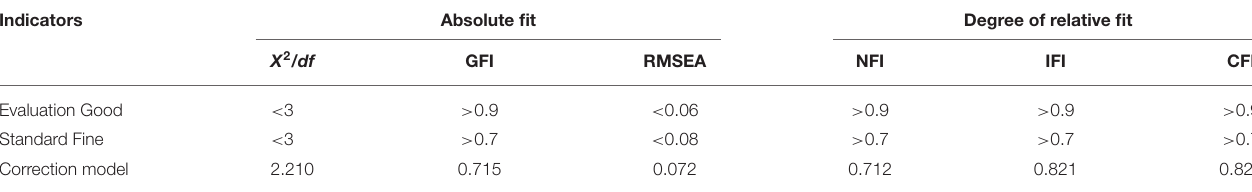
TABLE 5 | Model fitting degree after modification.